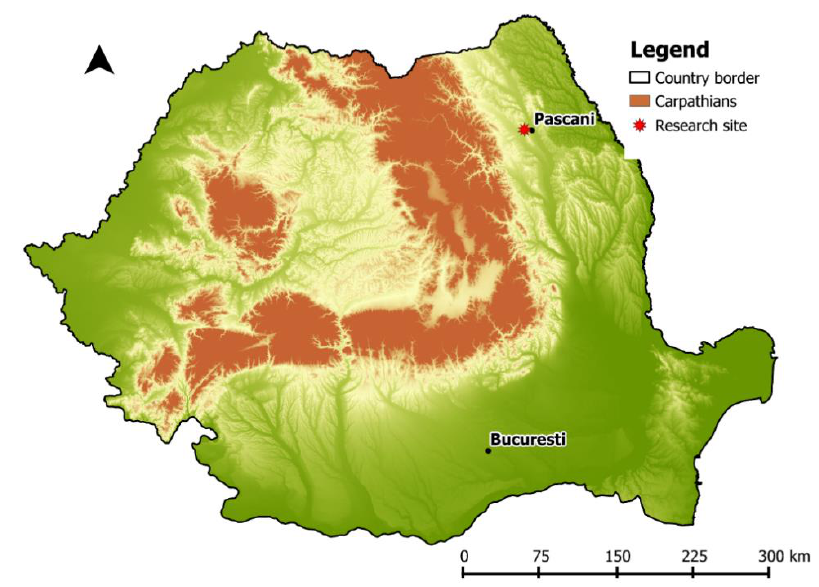
Figure 1. Location of research